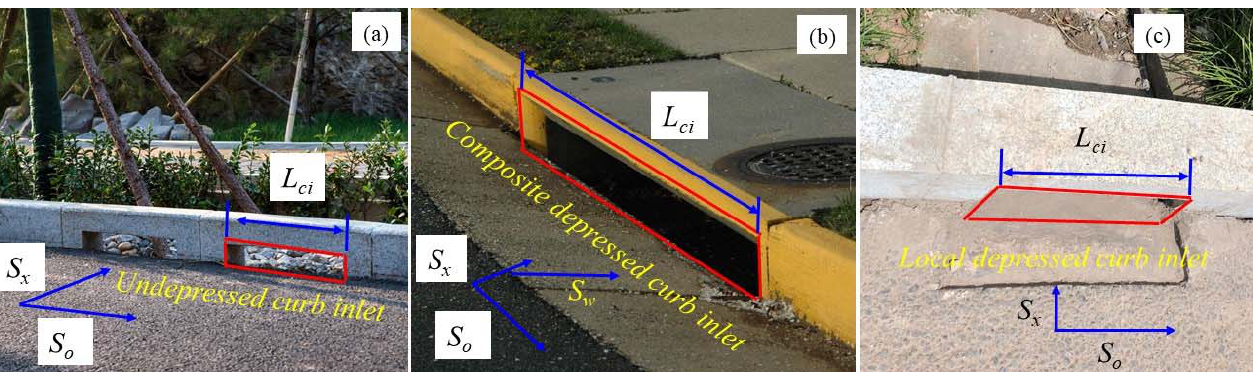
Figure 1. ( a ) The plane view of the simulation domain, and the cross sectional view of A–A for three types of curb inlets: ( b ) undepressed (one cross slope S x for the road surface), ( c ) composite section (two cross slopes: S x for the road and S w for the gutter over a width of w com ), and ( d ) local depressed (same to composite depressed curb inlet which only depressed in the curb opening and gutter part, see Figure 2c).